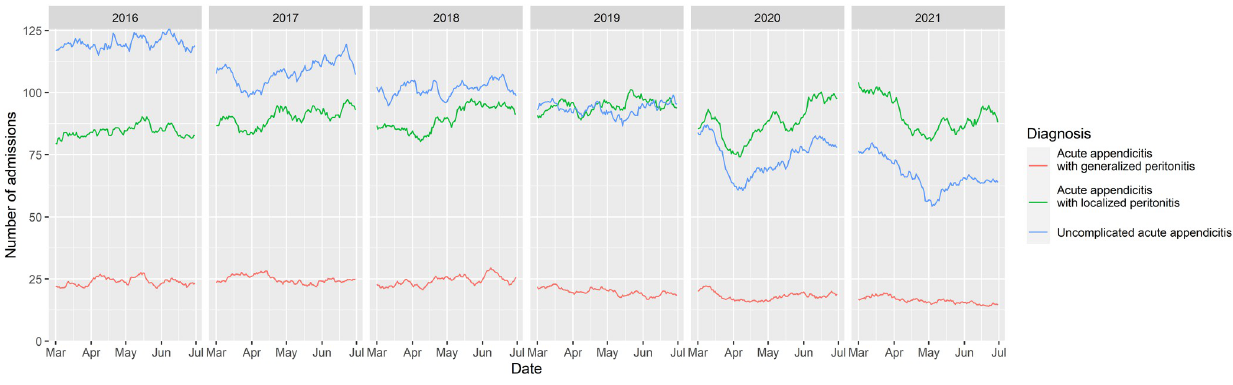
PLOS ONE | https://doi.org/10.1371/journal.pone.0270241 November3,